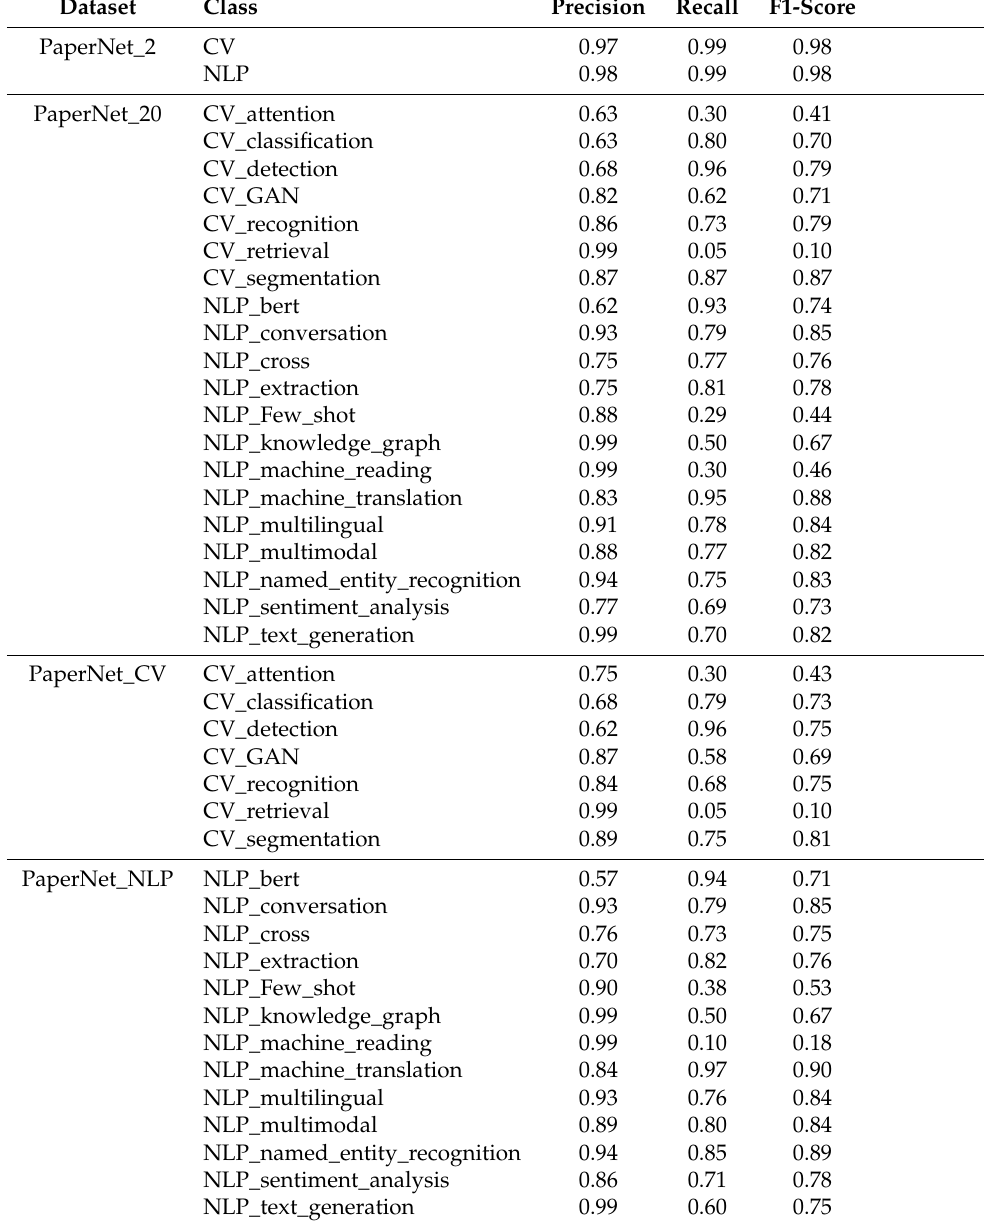
Table A4. Detailed results of the SVM